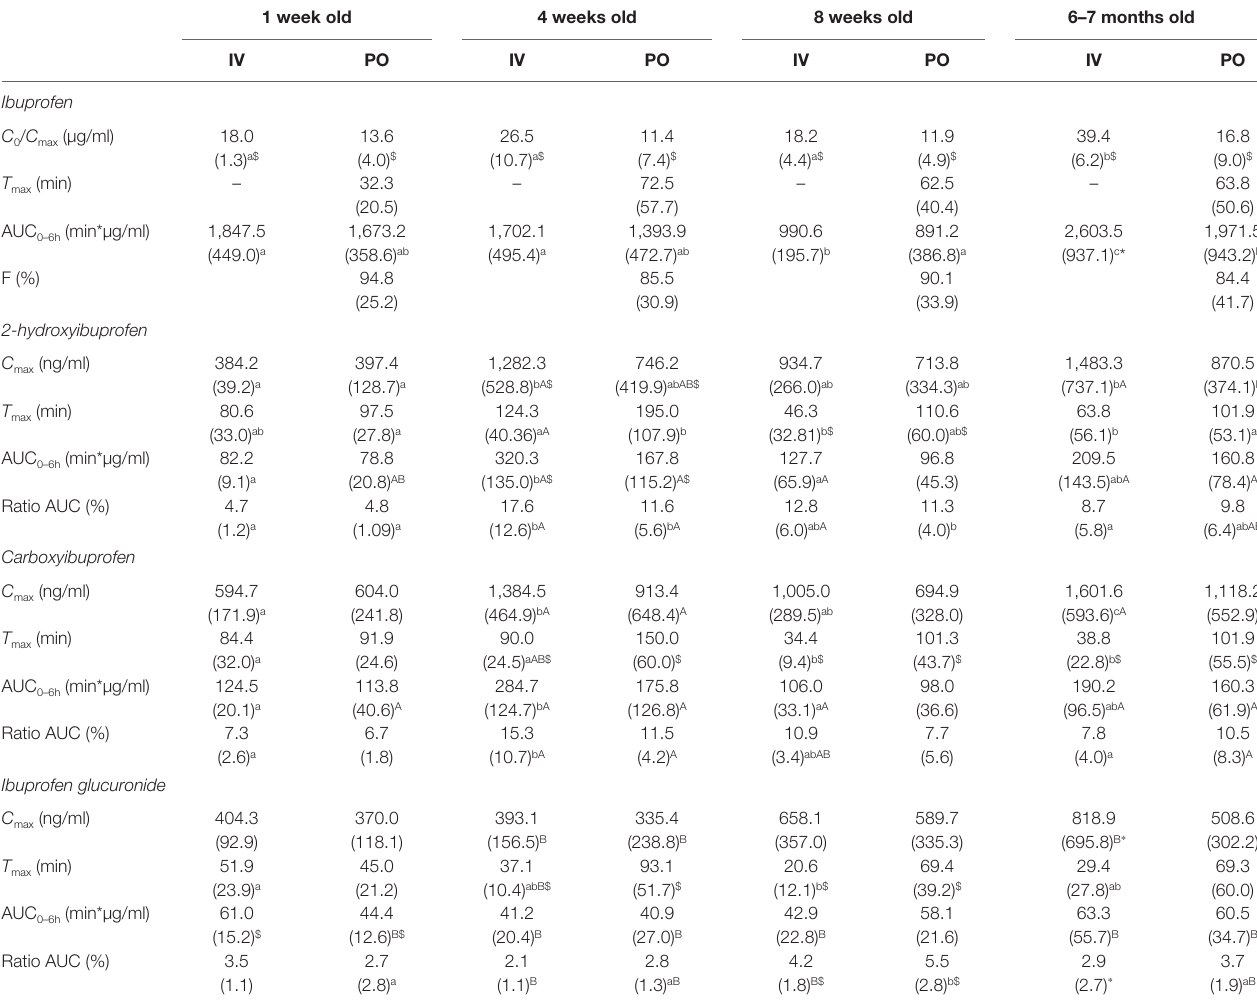
TABLE 1 | The mean values of the pharmacokinetic parameters (standard deviation, SD) of ibuprofen and its main metabolites, 2-hydroxyibuprofen, carboxyibuprofen, and ibuprofen glucuronide after intravenous (IV) or oral (PO) administration of 5 mg/kg BW ibuprofen to pigs aged 1 week, 4 weeks, 8 weeks, and 6–7 months (each time, 8 pigs, 4 ♂ , 4 ♀